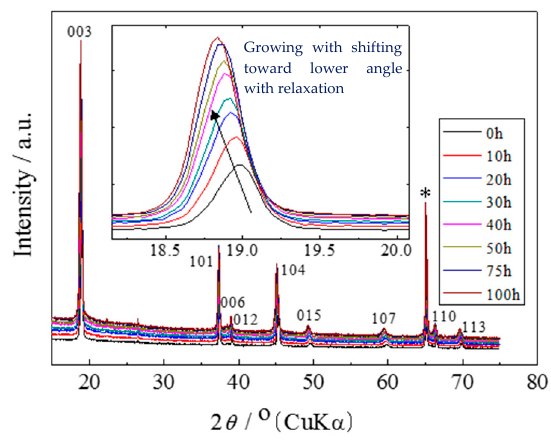
Figure 2. X-ray diffraction patterns of Li 0.12 Ni 0.874 Co 0.090 Al 0.036 O 2 obtained during relaxation time after the termination of lithium extraction. Diffraction patterns measured after relaxation up to 100 h are superimposed on each plot. Asterisk marks (*) indicate the diffraction peaks of aluminum foil current collector. Diffraction profiles around 003 reflections are enlarged in the inset.